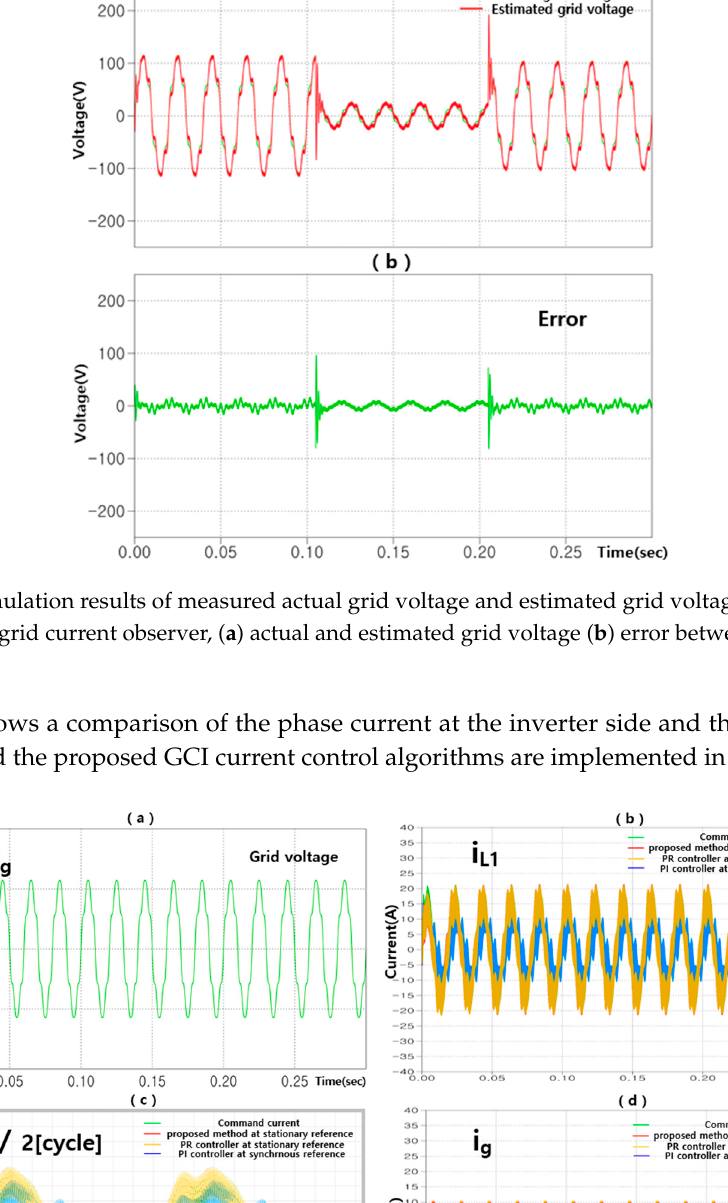
Figure 7. Simulation results of grid voltage and phase current responses of the GCI current control system. ( a ) grid voltage, ( b ) inverter side current ( c ) grid side current at a full time range and ( d ) zoomed in inverter side current,